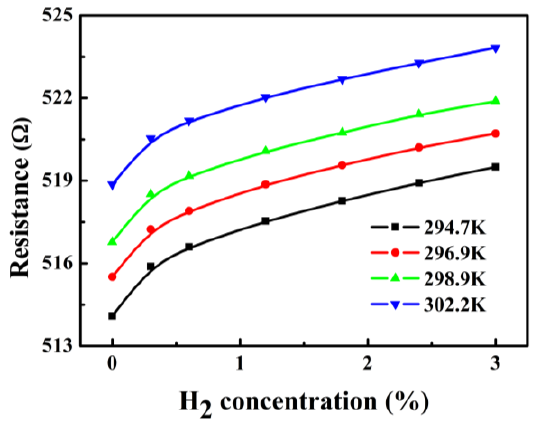
Figure 6. The variations of the resistance of the PdNi film with H 2 concentrations measured at different temperatures.